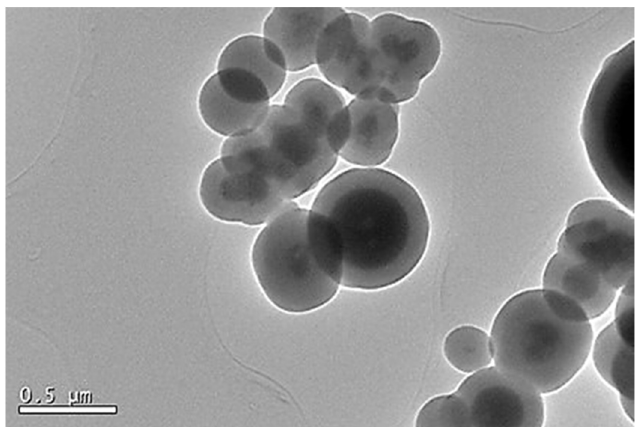
Figure 2. Transmission micrographs of Fe 3 O 4 @SiO 2 nanoparticles (Method